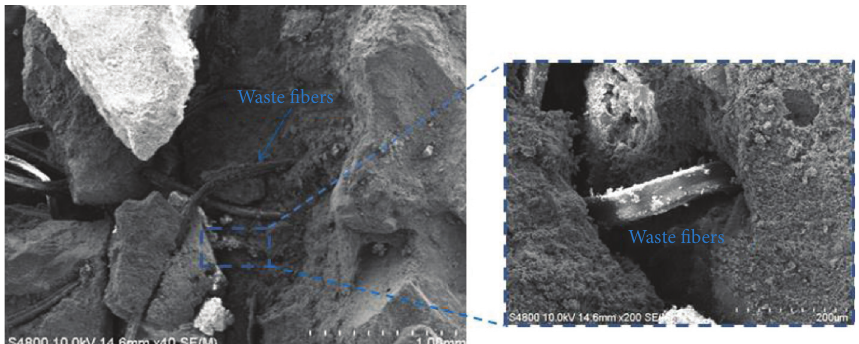
Figure 10: Micromorphology of waste